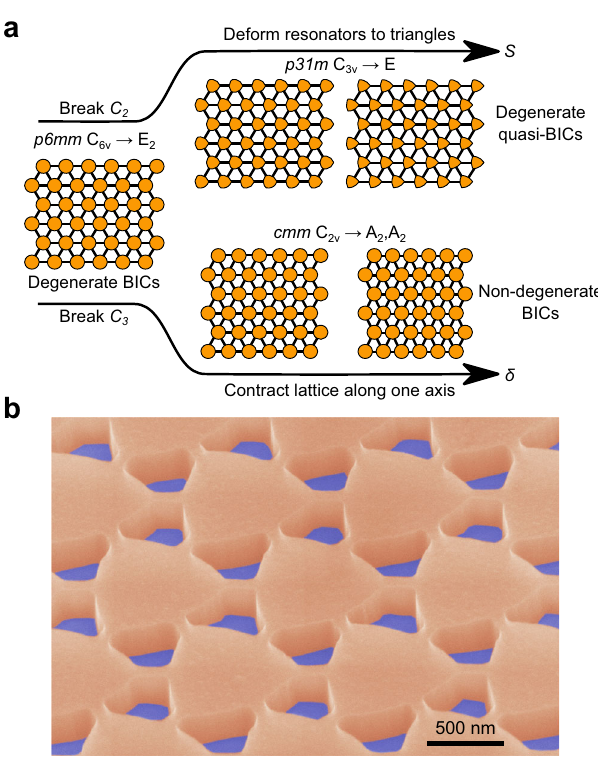
Fig.2|Resonatorandlatticedeformationstobreak C 2 and C 3 symmetries.a By deforming the circular resonators into triangles, C 2 symmetry can be broken (an operation that preserves C 3 ). Correspondingly, C 3 symmetry can be broken by contracting the lattice along one axis (an operation that preserves C 2 ). From these two deformations, we de fi ne symmetry-breaking parameters S and δ to denote the strength of C 2 and C 3 symmetry breaking, respectively. b False-color scanning electron micrographof afabricated siliconmetasurface on afused silica